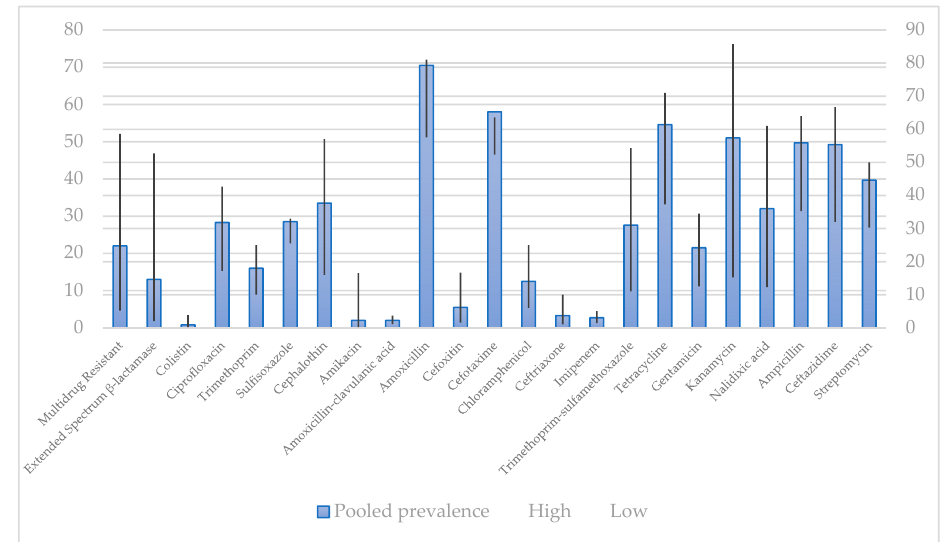
Figure 2. Pooled prevalence of antibiotic resistance isolates in humans by disk diffusion method, % [161].